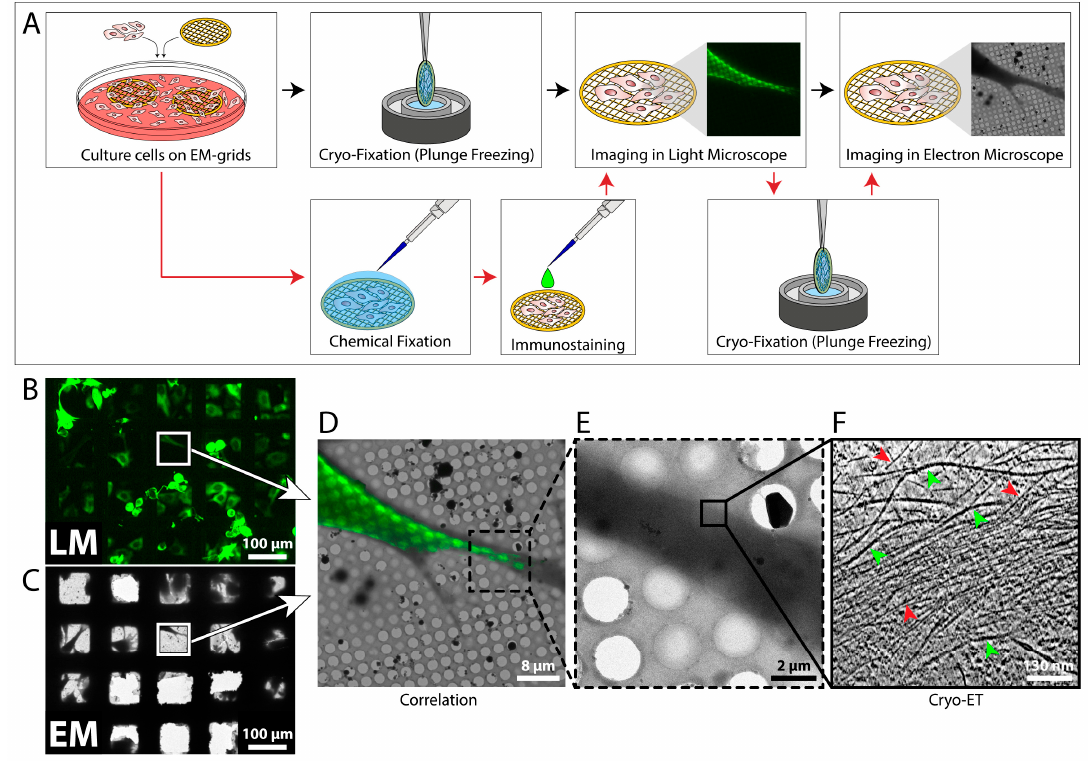
Figure 5. Correlative light and electron microscopy (CLEM). ( A ) Workflow for cryo-CLEM (black arrows) and traditional CLEM (red arrows). For cryo-CLEM, cells cultured on EM grids are vitrified in liquid ethane and imaged in a cryo-light microscope. Next, the grid is transferred to a cryo-electron microscope and the desired positions are found and imaged. Cryo-ET data acquisition is performed at high magnification. For traditional CLEM, cells cultured on grids are chemically fixed and labeled using conventional immunostaining procedures. Next, cells are imaged by fluorescence light microscopy at room temperature, vitrified, and imaged in a cryo-electron microscope. ( B ) MEF cells expressing emerald-vimentin were grown on an EM grid and analyzed by fluorescence microscopy. ( C ) The same region of the grid as in B was identified and imaged in the cryo-electron microscope. ( D ) Overlay of the fluorescence and electron microscopic images of the MEF cell framed in B and C. ( E ) Higher magnification image of the dashed area in D. Cryo-ET data acquisition was conducted at the area marked by the black box. ( F ) A 33 nm thick slice through the cryo-tomogram acquired at the area marked in E. Individual vimentin (green arrowheads) and actin (red arrowheads) filaments are detected in the cytoplasm of the cell.